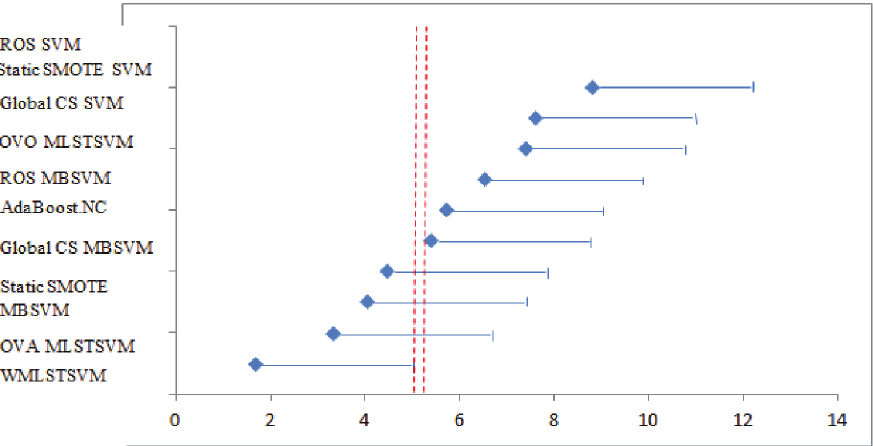
Fig. 3. Average rank comparison of non-linear